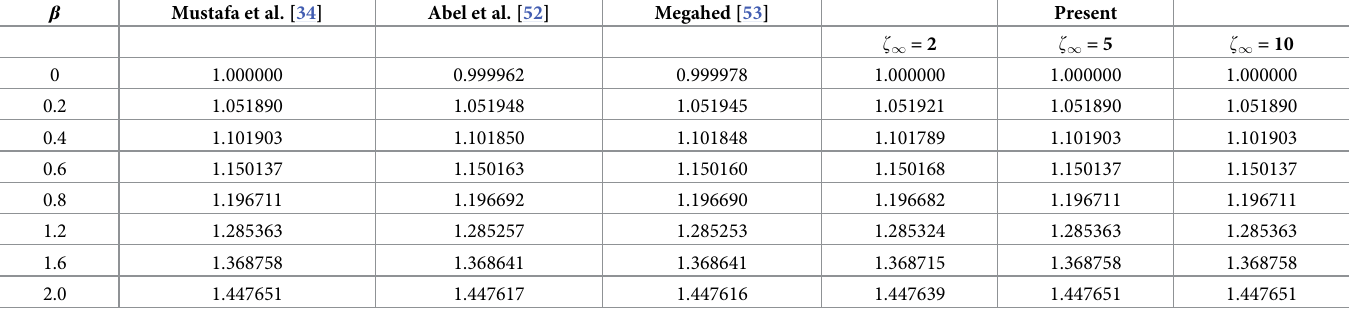
Table 3. Comparison with wall velocity gradient − F @ (0)obtained by Mustafa et al. [34], Abel et al. [52] and Megahed [53] for different values of β when λ = ( c / a )= 0.